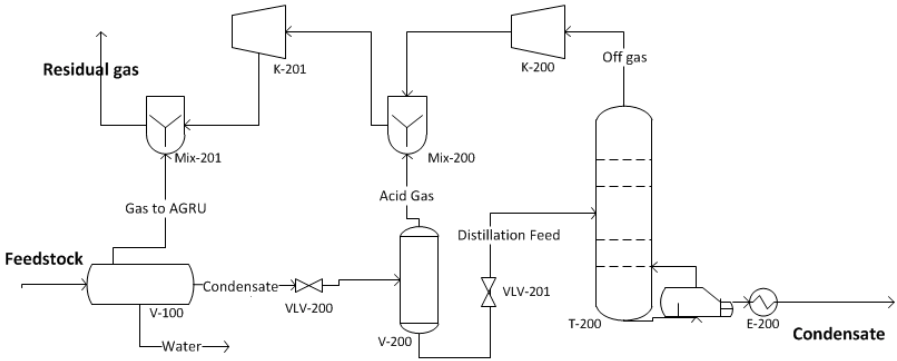
Figure 1. Process flow diagram of the gas stabilization unit.